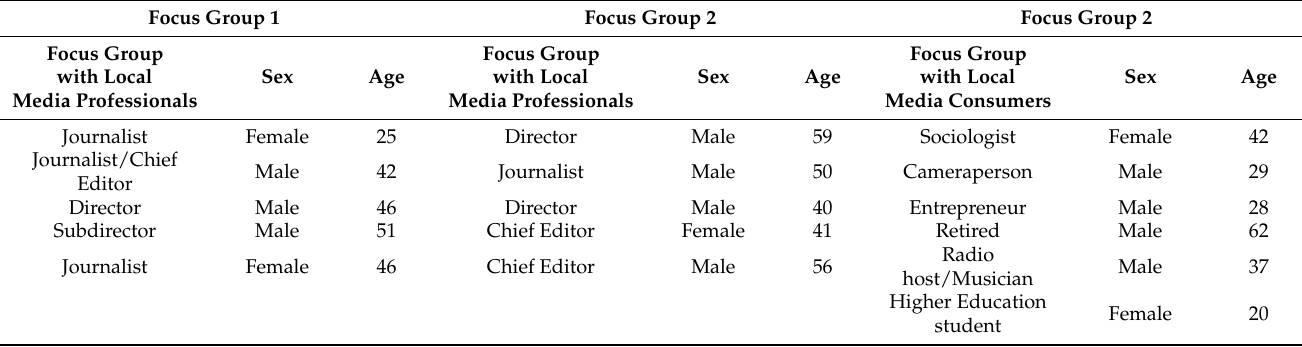
Table 2. Distribution and characteristics of participants by focus group.